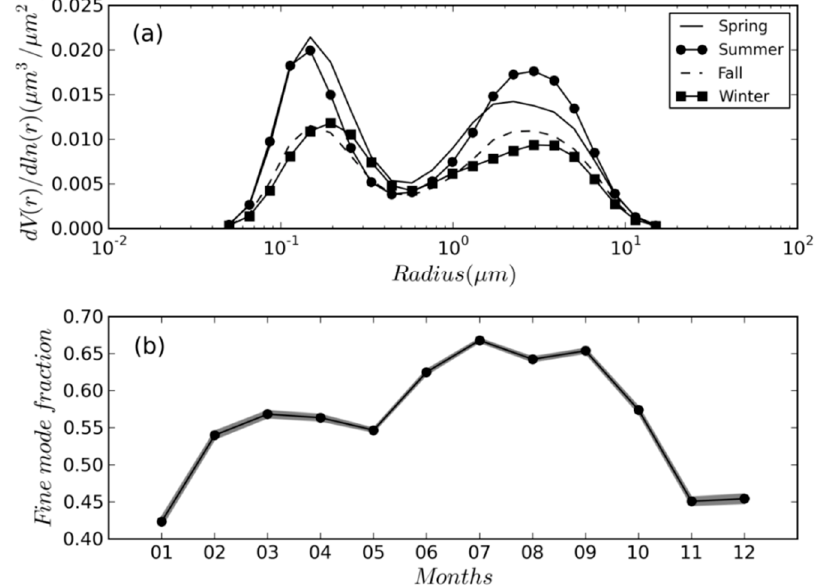
Figure 6. ( a ) Seasonal volume size distributions and ( b ) mean monthly fine mode fraction of aerosols in the period from December 2008–May 2015 at the AERONET Arcachon lagoon station. The grey area is associated to the 95% confidence interval.